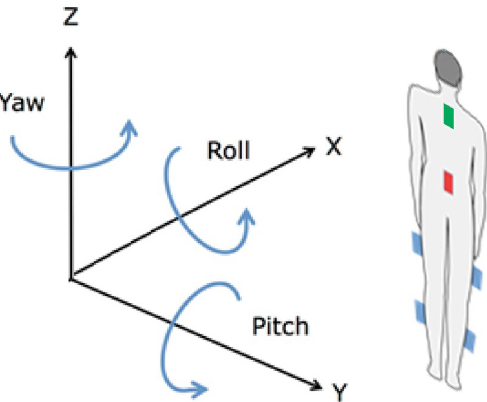
Figure 1. Placement of devices (coloured rectangles) on the body, various configurations: one-device—red or green, six-devices—red, green and